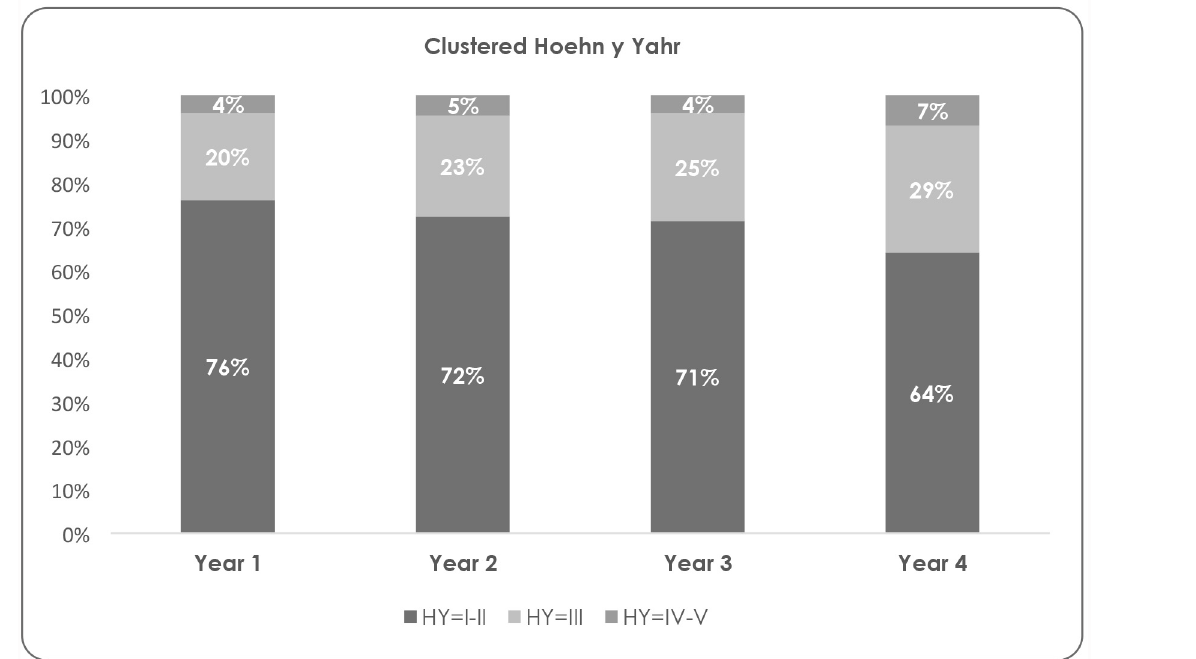
Fig 1. Patients distribution by disease severity according to clustered Hoehn and Yahr staging. € 3,395.28, n = 110) for mild, € 6,911.04 (SD: 12,698.30, n = 50) for moderate and € 5,310.24